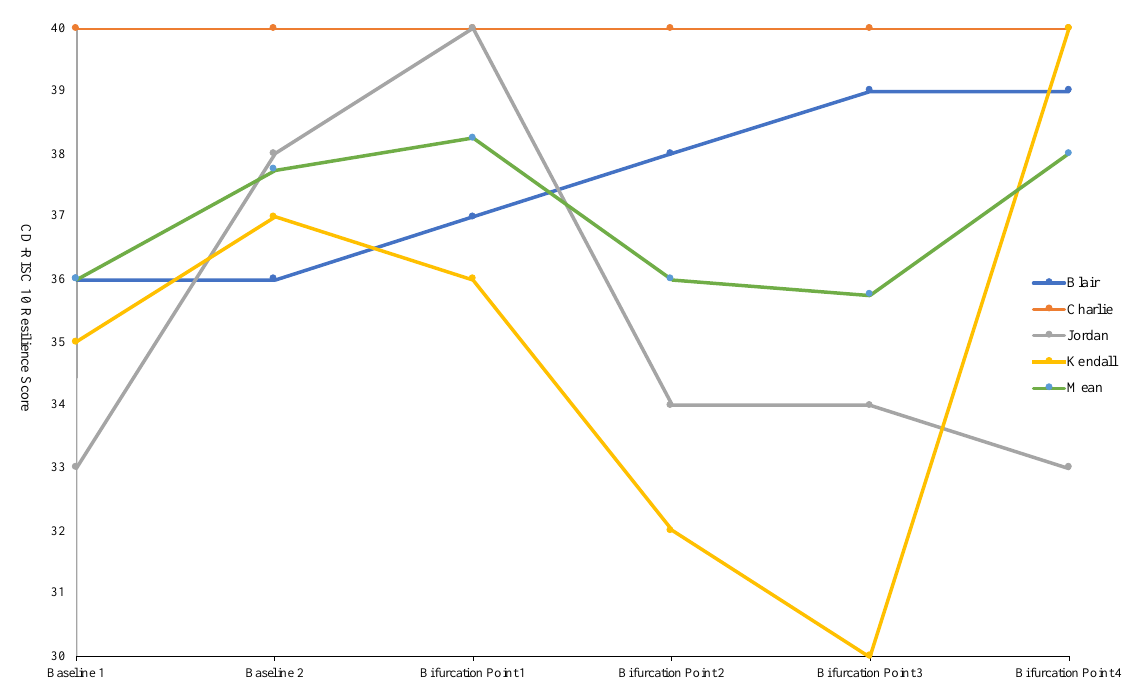
Figure 1. The individual CD-RISC10 scores of challenge team members across the time points of the 100 Peak Challenge. The time points of the challenge where the data were collected was determined by the Challenge Team, the Support Team, and the conditions at the base camps. Hence, they were not standardised. Below is some additional information to add context to these time points in the graph: Baseline 1—University in London, England. Completed 3 weeks before the challenge started. Baseline 2—Fort William, Scotland. Completed 24 h before the challenge started. Bifurcation Point 1—Fort William, Scotland. Completed on day 1 of the challenge. Bifurcation Point 2—Newton Stewart, Scotland. Completed on day 7 of the challenge. Bifurcation Point 3—Keswick, England. Completed on day 14 of the challenge. Bifurcation Point 4—Merthyr Tydfil, Wales. Completed on day 24 of the challenge. Table 2. A summary of the qualitative results from the video diaries and focus groups (part 2).